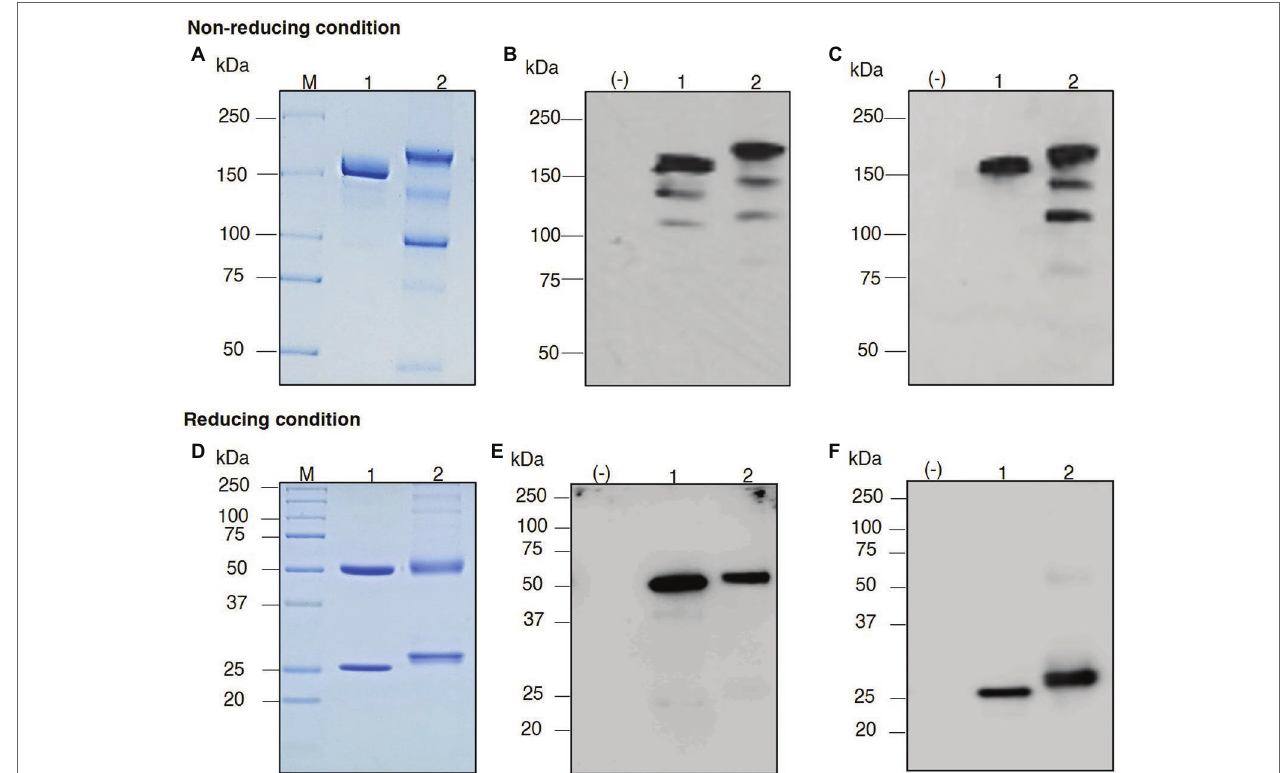
FIGURE 4 | Sodium dodecyl sulfate–polyacrylamide gel electrophoresis (SDS–PAGE) of purified plant-produced anti-RANKL mAb under nonreducing conditions and reducing conditions. Crude extracts from the infiltrated leaves were purified by a Protein A affinity chromatography column. The purified product was analyzed by SDS–PAGE staining with Coomassie Blue (A,D) . For western blot analysis, the separated proteins in the polyacrylamide gel were transferred to a nitrocellulose membrane, and the membrane was detected with either HRP-conjugated anti-human gamma chain antibody (B,E) or anti-human kappa chain antibody (C,F) . Lane M, Protein ladder; Lane ( − ), Wild-type crude extract; Lane 1, Commercial denosumab; Lane 2, Purified plant-produced anti-RANKL